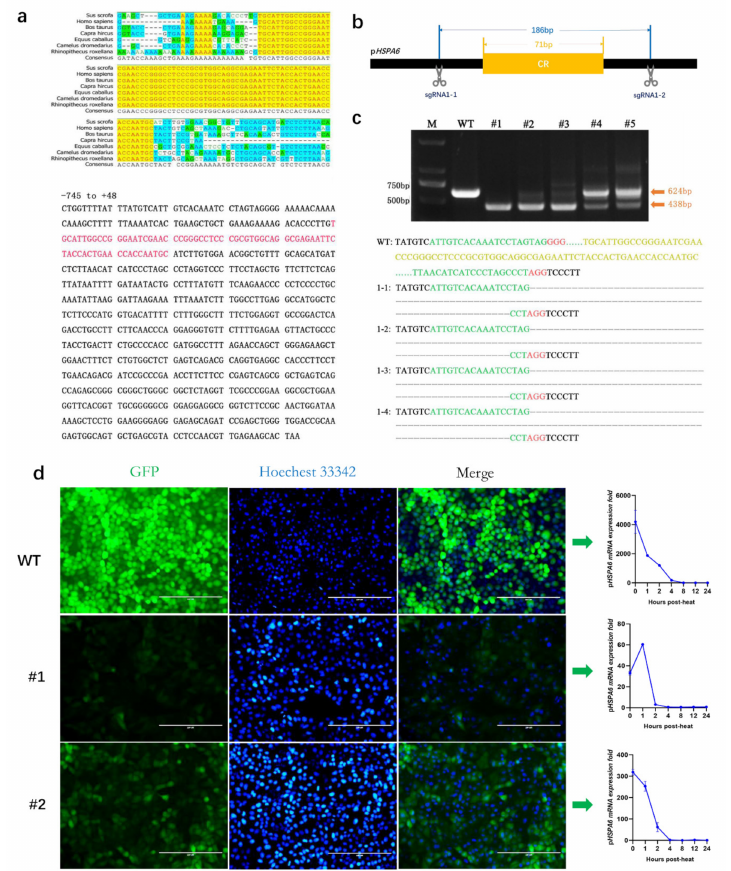
Figure 4. Effect of CR on the expression of p HSPA6 . ( a ) CR was found by blasting the HSPA6 promoter of seven species, and the position of CR was located in the p HSPA6 promoter. ( b ) Strategy of sgRNA1- 1 and sgRNA1-2 knock-in into p HSPA6 . ( c ) Selecting of positive clones using PCR. Primers are shown in Table 2; diagram of positive clone #1 after pLB vector cloning. ( d ) Fluorescence microscopy and qPCR analysis of p HSPA6 expression in WT and positive clone cells (data show the mean ± S.E.M. in triplicate